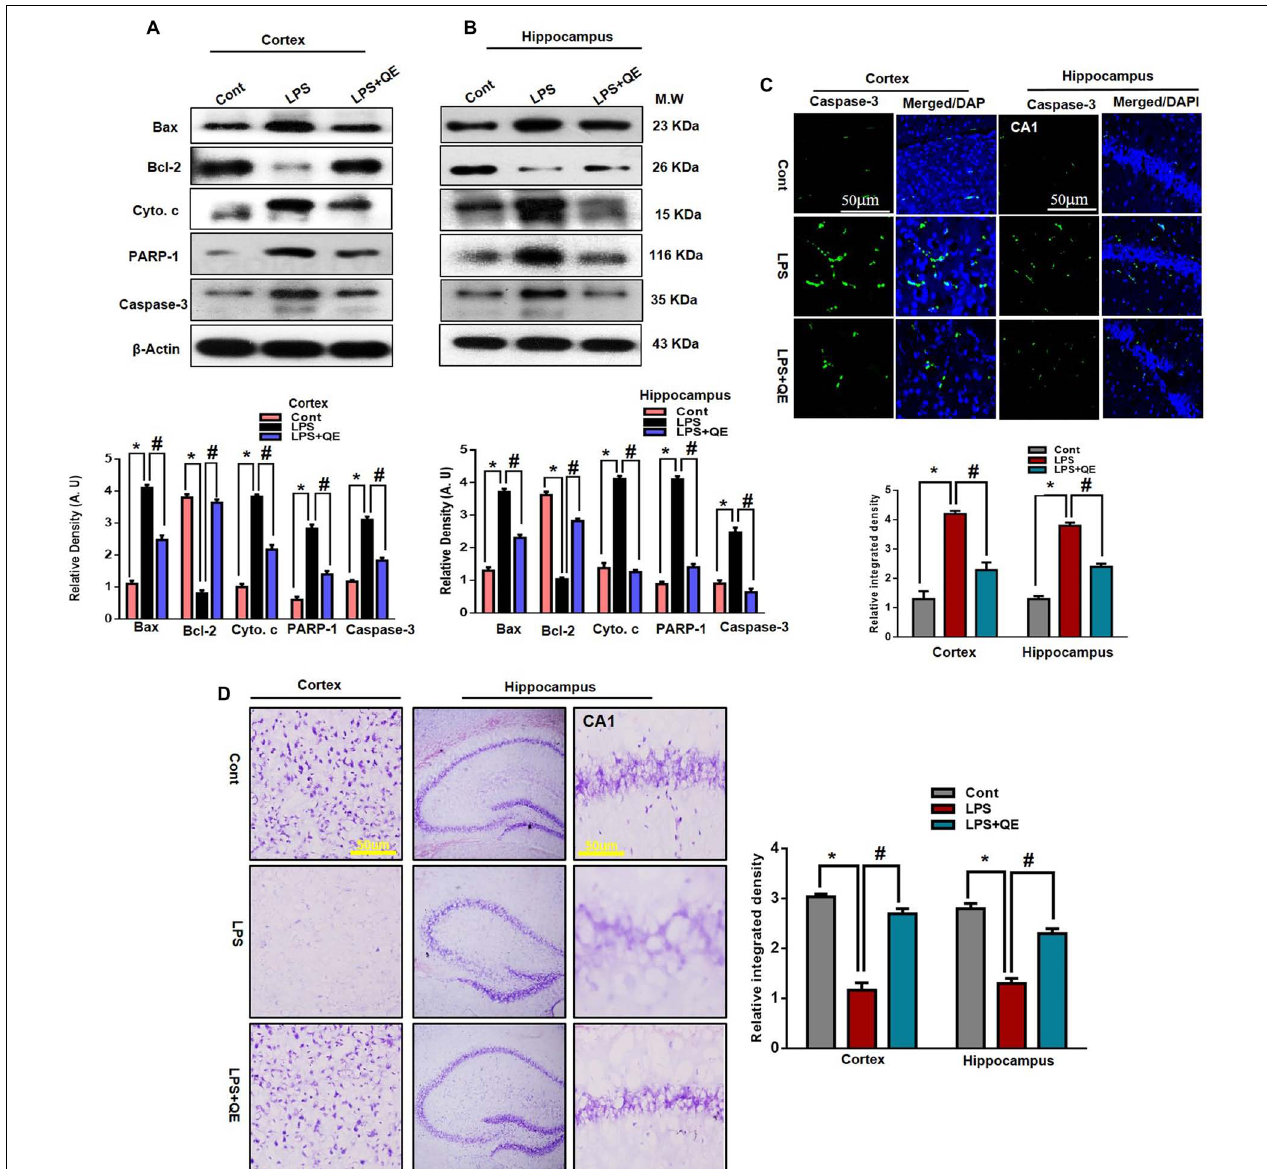
FIGURE 7 | LPS-induced neuronal apoptotic pathway prevented by quercetin in the cortex and hippocampus. (A,B) Western blotting of Bcl-2, Bax, Cyto. c, Caspase-3 and PARP-1 proteins; their differences in the cortex and hippocampus of mouse brains are represented by a histogram. β -Actin was used as a loading control. The quantified density values are shown in arbitrary units (A.U.) as the means ± SEM for the respective shown protein (8 mice/group). ( C ) Representative immunofluorescence images and the quantified histogram of Caspase-3 in the cortex and hippocampus of adult mice (5 mice/group). Magnified 10 × . Scale bar = 50 µ m. ( D ) Representative immunohistochemical images (Nissl staining) and the quantified histogram of the survival neuron reactivity and integrated density in the cortex and hippocampus region of adult mice. The expressed data are relative to the control. ∗ Significantly different from the control; # significantly different from LPS-treated group. Significance: P <